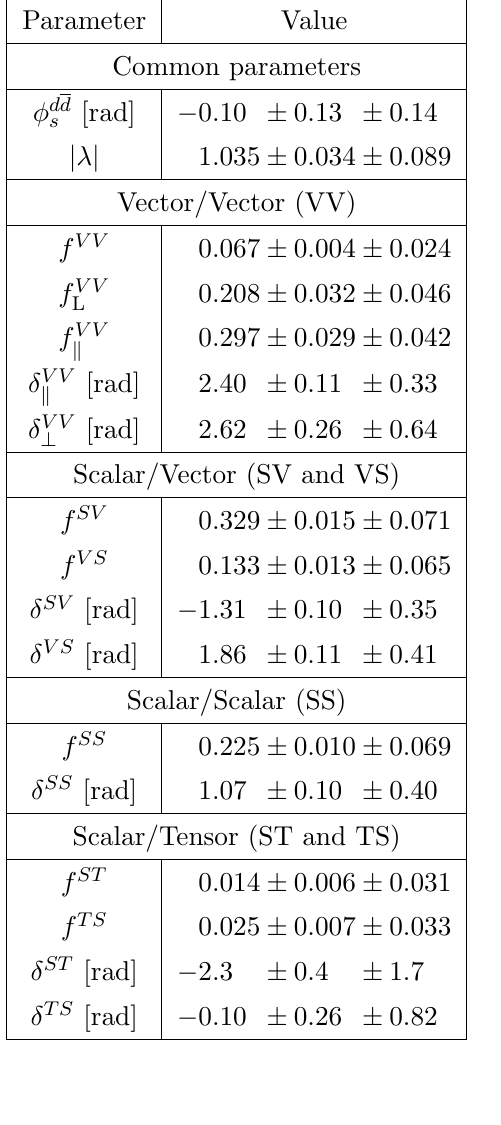
Table 5 . Results of the decay-time-dependent amplitude (cid:12)t to data. The (cid:12)rst uncertainty is statistical and the second uncertainty is